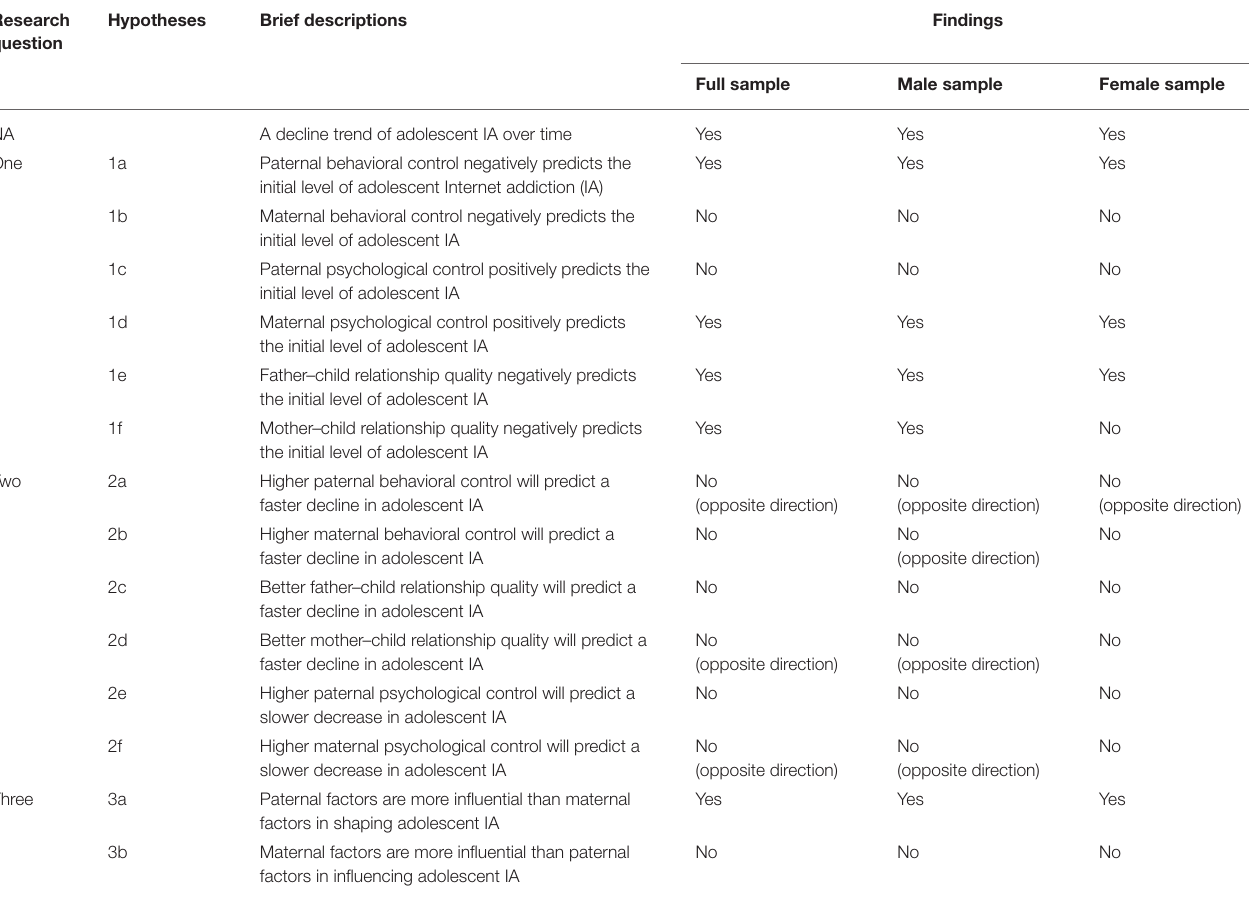
TABLE 1 | Summary of hypotheses and findings of the present